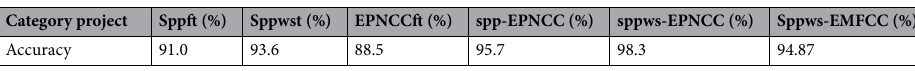
Table 8. Accuracy of each training category.